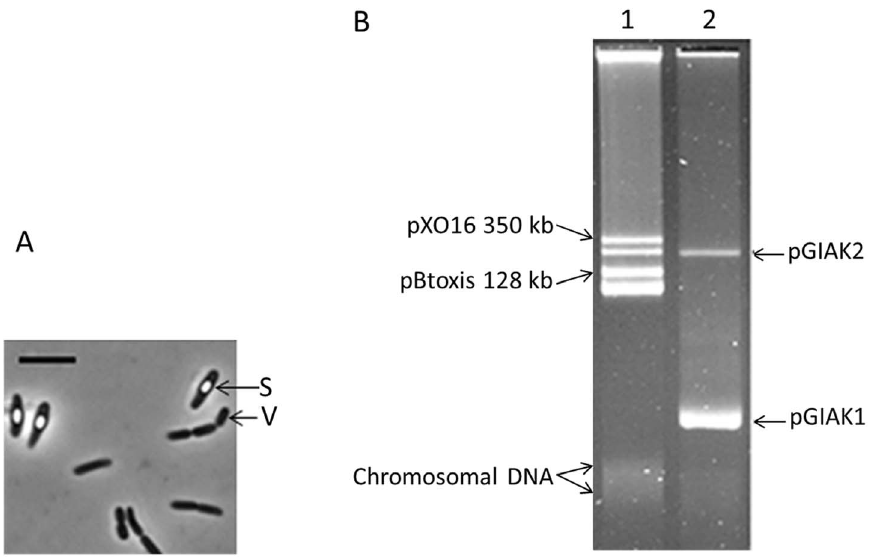
Figure 1. Cells and plasmids of strain JMAK1. (A) Bacterial cells were observed under a BX50 phase contrast microscope (Olympus, Japan). V, vegetative cell; S, spore. The bar is 5 m m. (B) Plasmid profile of strain JMAK1. The plasmid preparation was run in a 0.5% agarose gel and stained with Ethidium Bromide. The chromosomal DNA referred to the degraded linear chromosomal material. Lane 1, B. thuringiensis serovar israelensis AND508; Lane 2,